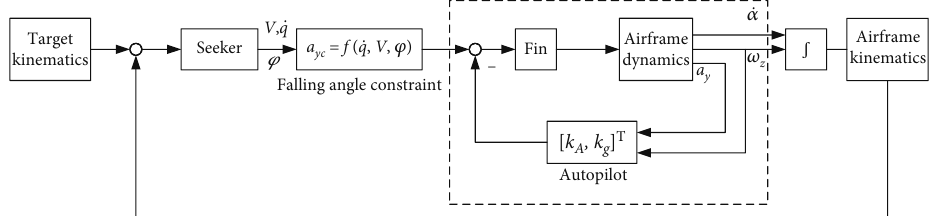
Figure 4: Guidance control model.